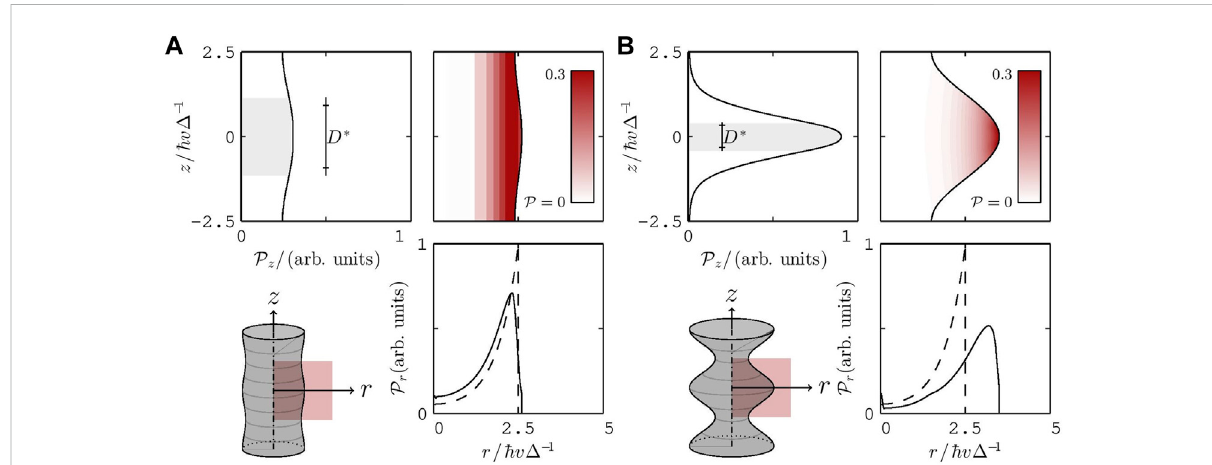
FIGURE 5 Probability density of a surface state of | j | = 1/2 in two rough nanowires of R = 2.5 Z v / Δ and D = 5 Z v / Δ . Panel (A) shows results for a slightly modulated nanowire with δ R = 0.1 Z v / Δ . Panel (B) shows results for a strongly modulated nanowire with δ R = Z v / Δ . Within each panel, the subpanels presents the probability density as a function of the axial coordinate z , as a function of the radial coordinate r and a combined representation in a 2D color map. For comparison, the dashed line indicates the radial probability density of a uniform nanowire with R = 2.5 Z v / Δ . The shadowed area of size Δ z = D * Z v / Δ represents the longitudinal region where the con fi nement probability is